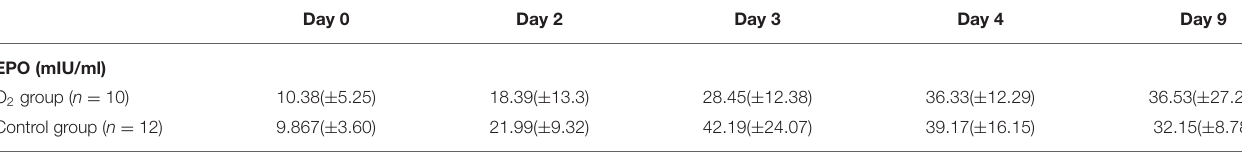
TABLE 2 | Evolution over time of EPO in O 2 group and control group expressed as mean ± (SD * ).